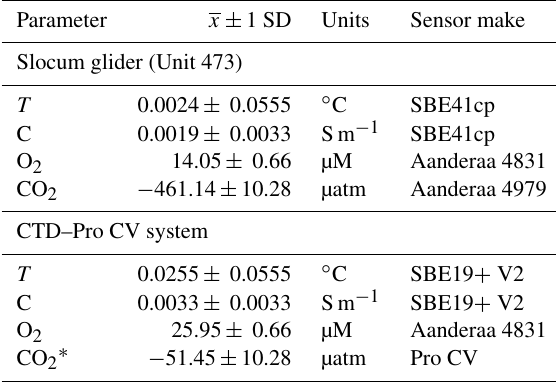
Table 1. Sensor offsets from DFO tank tests on 27 August